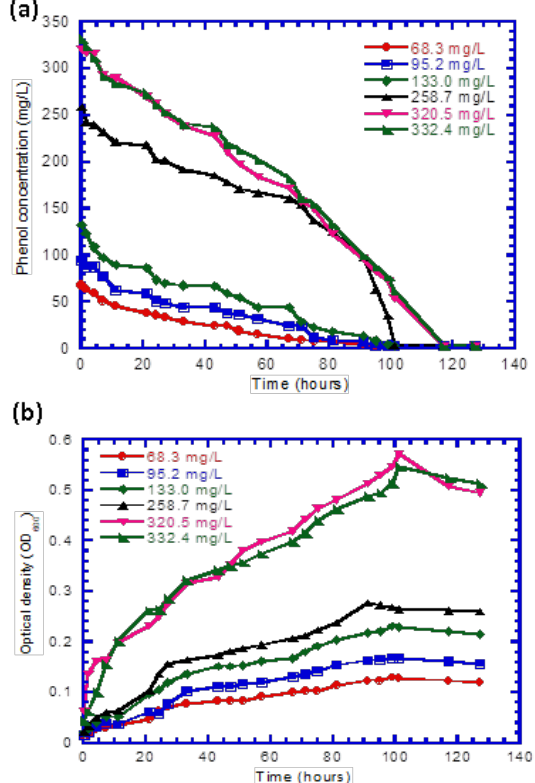
Figure 5. Batch kinetic tests for phenol degradation and cell growth: ( a ) phenol ( b ) P. Putida cells.